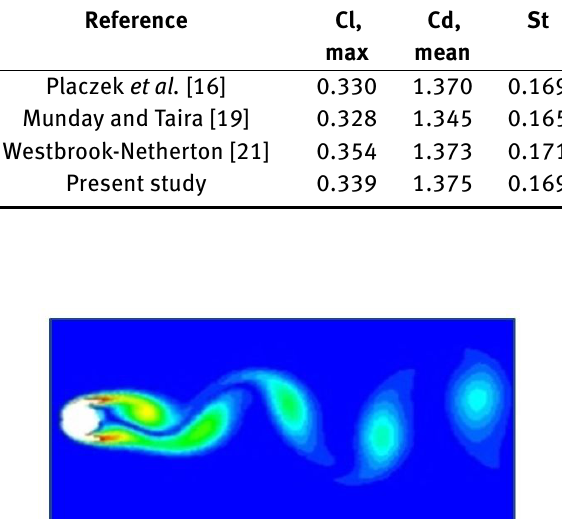
The computed mean drag coefficient, CD, lift coefficient amplitude, CL, and Strouhal number, St, were compared with the available results reported in the literature. Table 1 depicts an acceptable agreement between the present re- sults and published data.